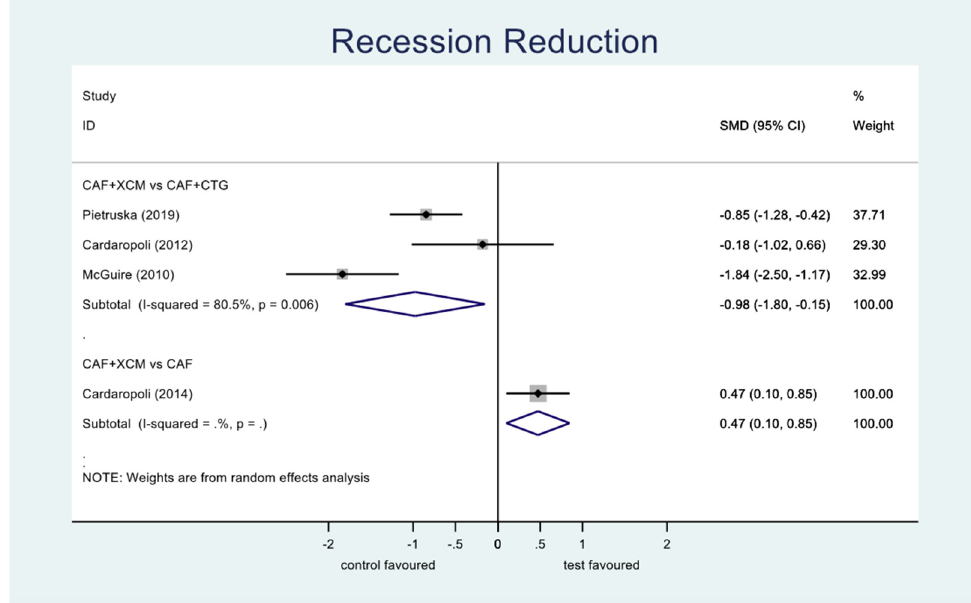
Figure 6. Forest plot relating to recession reduction.